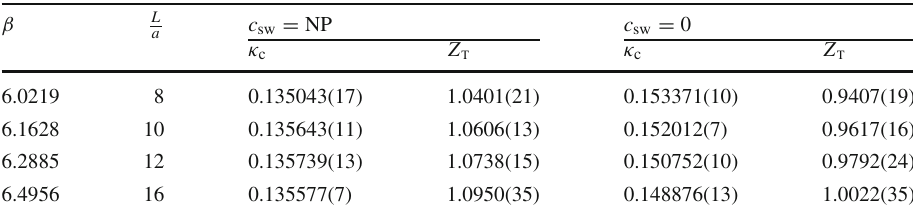
, L / a ) at constants Z T ( g 2 0 L = 1 /μ N f = 0, scheme had for α = 1 /